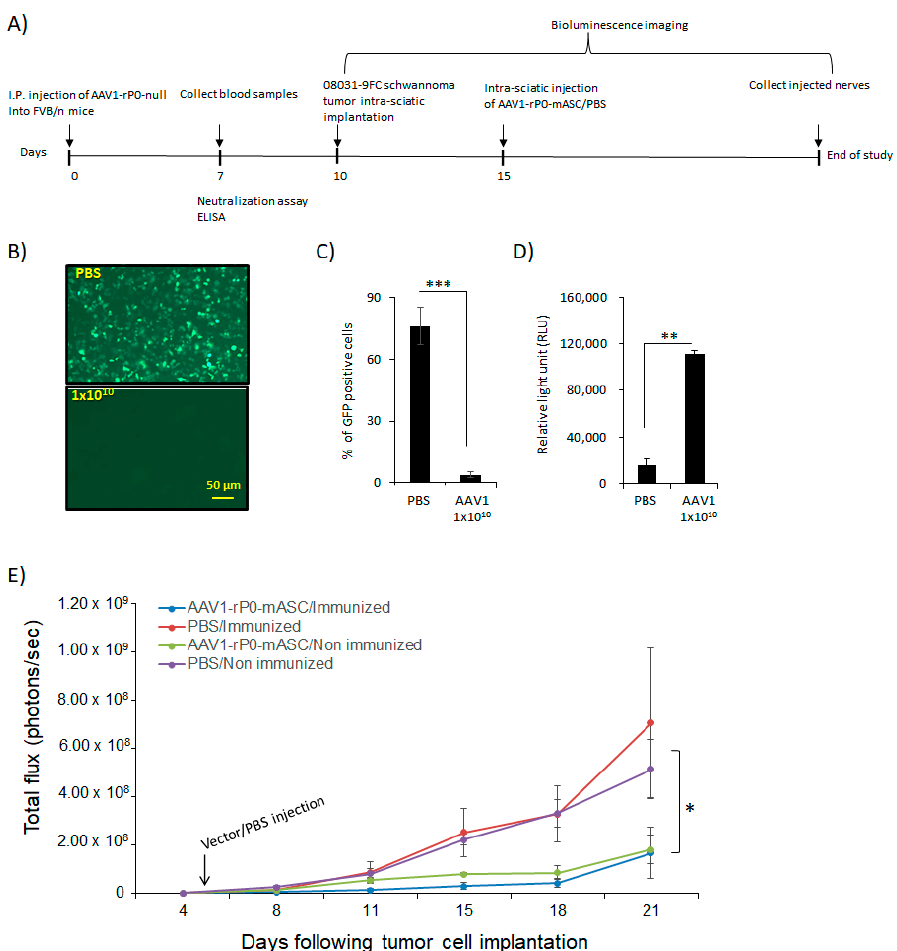
Figure 4. AAV1-rP0-mASC intra-tumoral injection of AAV1-preimmunized immunocompetent mouse schwannoma model slows tumor growth. ( A ) schematic diagram for the experimental design of the effect of AAV1 pre-existing immunity on the efficacy of the intratumoral AAV1-rP0-mASC